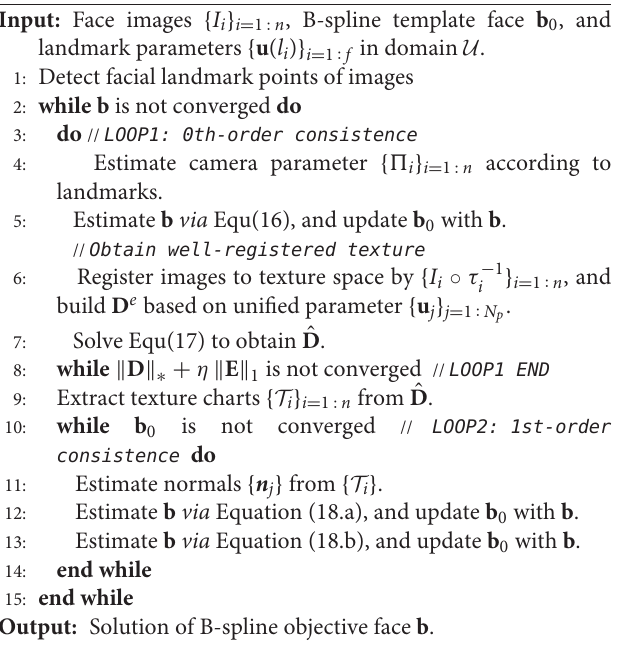
Algorithm 1 : Iterative Algorithm for B-spline Face